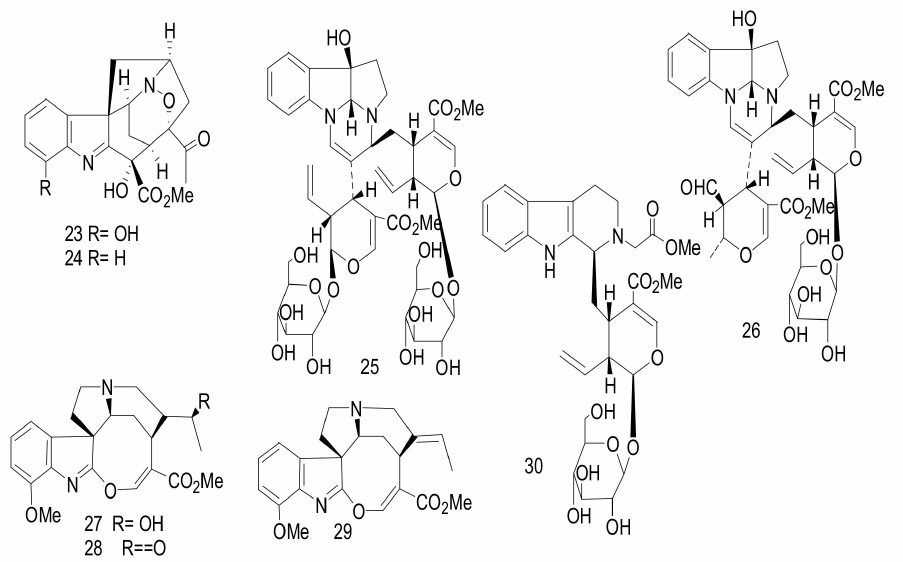
Figure 6. Compounds 23 – 30